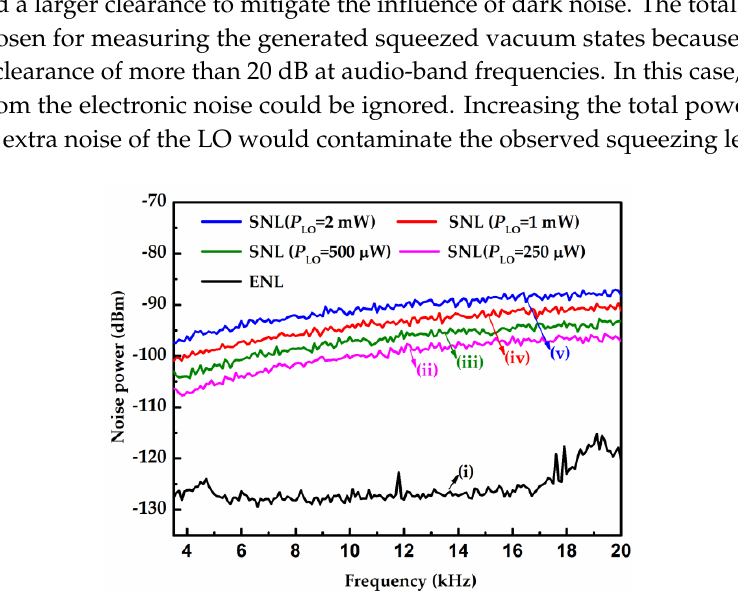
Figure 6. Linearity and clearance of photodetectors in the BHD system: Curve (i), the ENL; and Curves (ii)–(v), the SNL versus the total power of the LO (250 μW, 500 μW, 1 mW and 2 mW). The measured threshold power of the OPO was 350 mW in the experiment. When the pump with the power of 100 mW and the CCF with the power of 100 μW were injected into the OPO, the